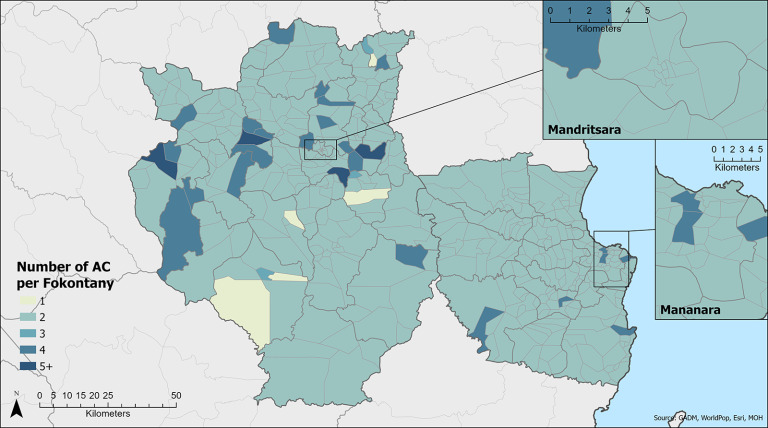
Number of ACs per Fokontany in MadagascarAbbreviation: ACs, agents communautaires (community health workers).